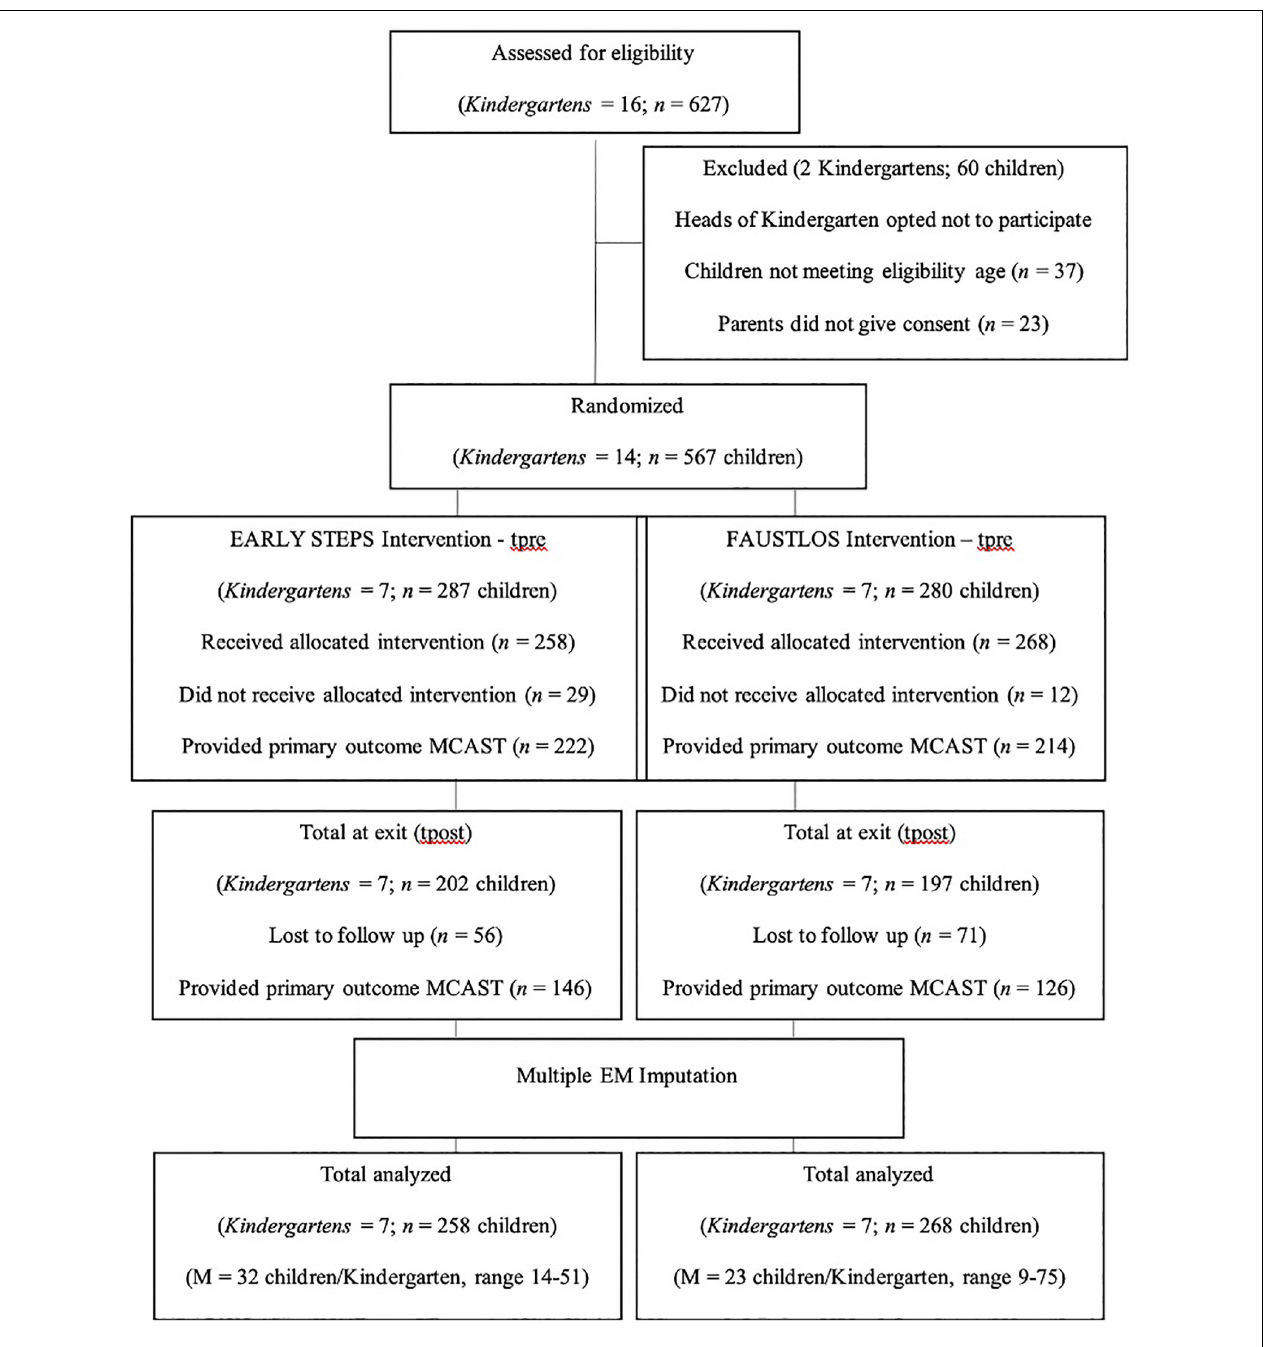
FIGURE 1 | Consort